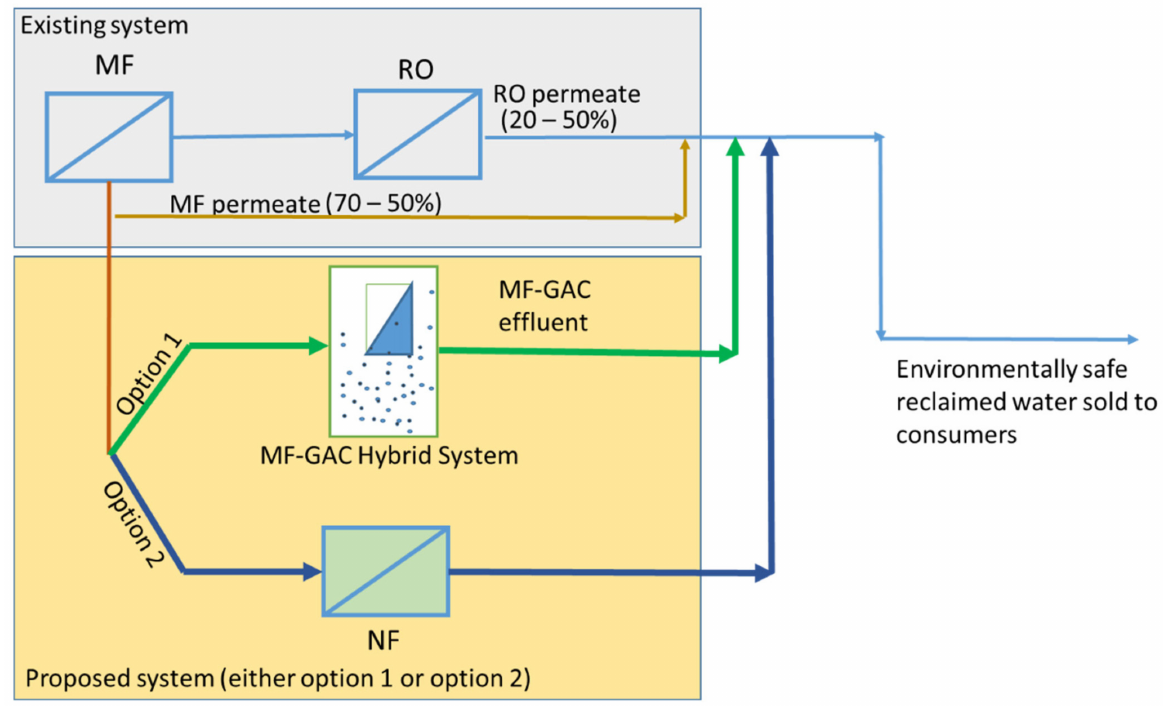
Figure 4. Proposed system for the WTP to produce environmentally safe reclaimed